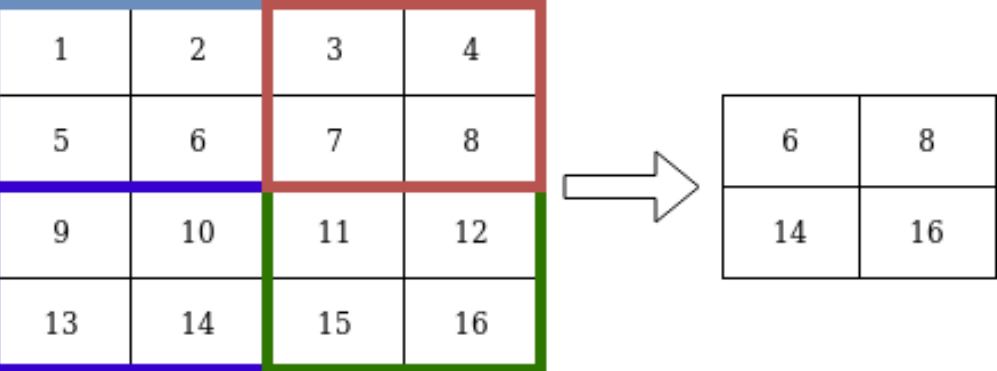
Figure 5. Max pooling with filter 2*2 and stride